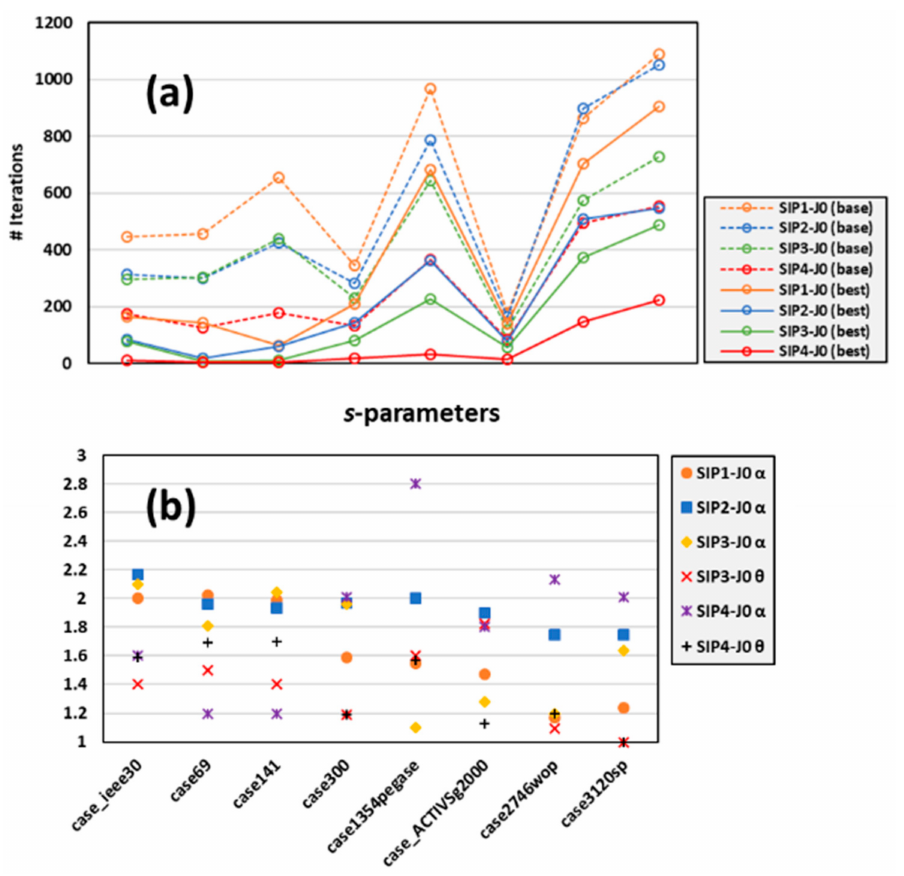
Figure 6. ( a ) Comparison of the total number of iterations of different linear Newton-SIP solvers, taking the s -parameters equal to 1. ( b ) Considered s